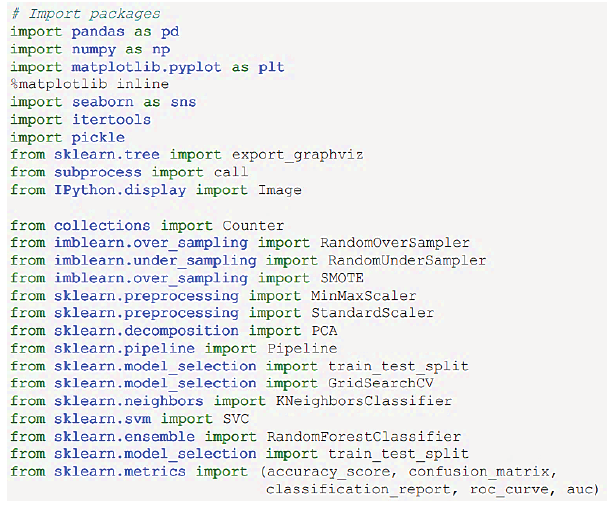
Fig. 5. Packages from Python.